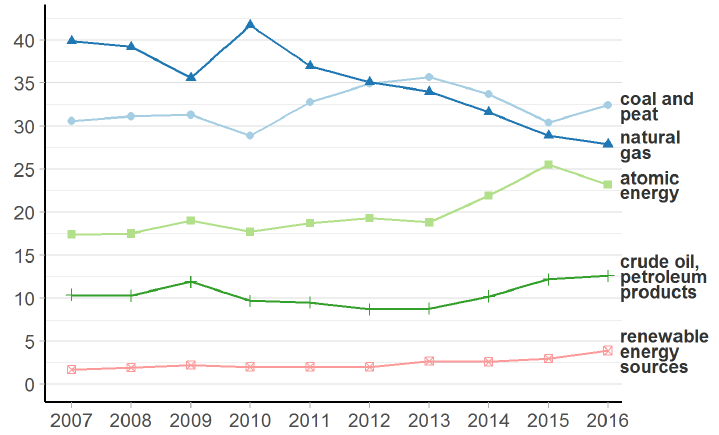
Figure 9. Dynamics of the structure of energy consumption in Ukraine by types of energy resources in percentages. Source of information: [88].